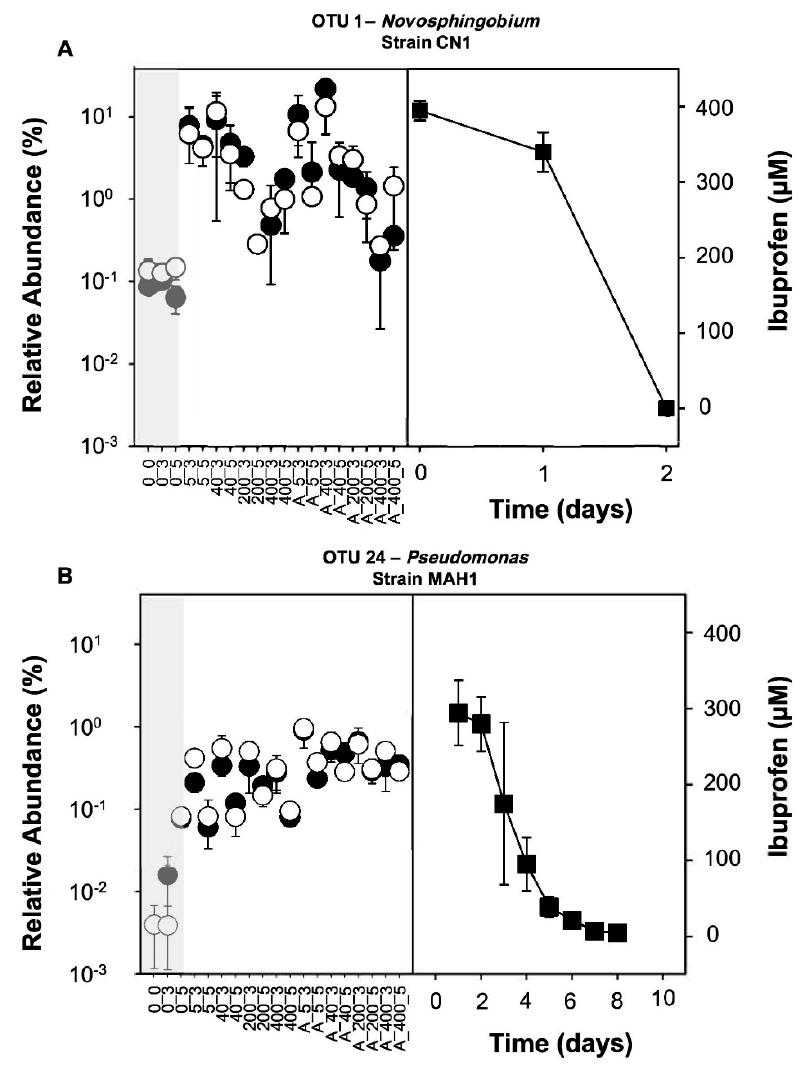
Figure 6. Effect of ibuprofen on the relative abundance of OTUs in 16S rRNA gene (DNA) and 16S rRNA (RNA or cDNA)-derived amplicon libraries from oxic hyporheic zone sediment microcosms (Figure 1) affiliating with ibuprofen-degrading strains Novosphingobium CN1 ( A ) and Pseudomonas MAH1 ( B ), and the capacity of both strains to degrade ibuprofen under oxic conditions. The grey box indicates unsupplemented oxic control microcosms. Values represent the arithmetic means of triplicates, and error bars indicate standard deviations. Filled and open circles, DNA and RNA (cDNA) level, respectively; filled squares, ibuprofen concentration. Sample code: A, amended with 1 mM acetate and ibuprofen per feeding; 0, 5, 40, 200, and 400 indicate supplemental ibuprofen concentrations in µM given per feeding; 0 ′ , 3 ′ , and 5 ′ correspond to samples obtained at the start of the incubation, and after the third and fifth refeeding, respectively. Sampling times for unamended controls were according to those of the 400 µM ibuprofen treatment.